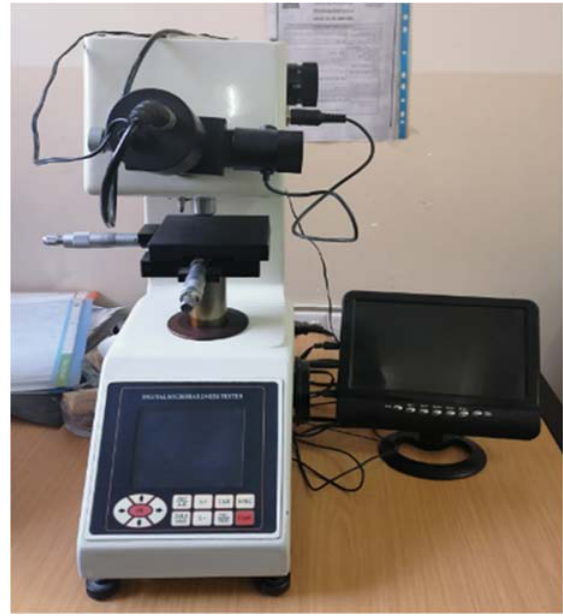
Fig. 7. Digital micro-hardness tester.